Question: Give a one-sentence summary of this figure.
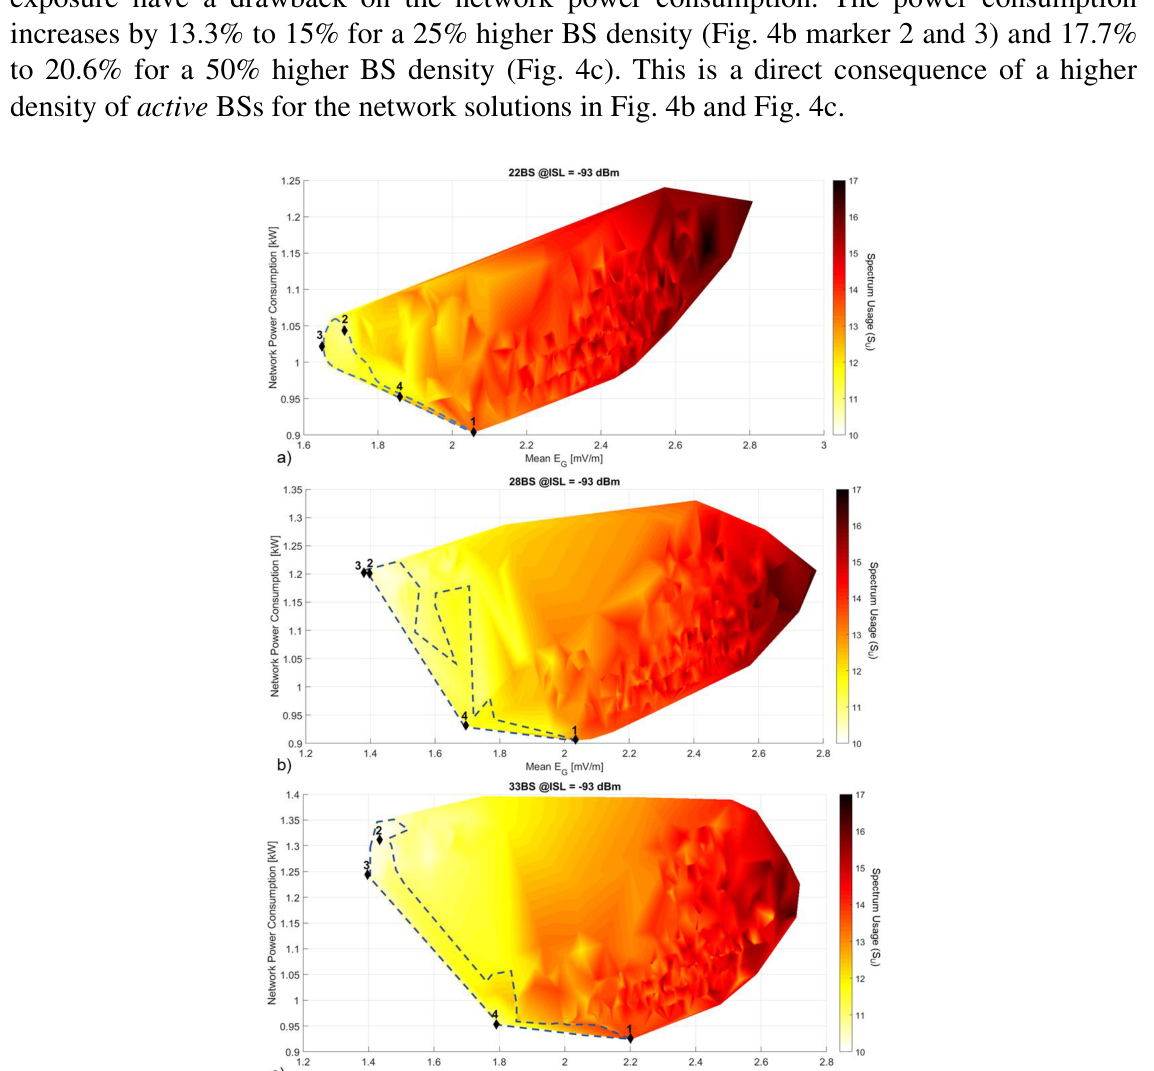
Answer: shows the generated objective optimization results for a) 22 BS (minimum to guarantee  coverage requirements, NBS), b) 28 BS (increase of BS locations by 25%) and c) 33 BS  (increase of BS locations by 50%) with an Interference Signal Level constraint   ISL = -93 dBm.